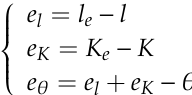
Table 5. The simulation parameters of SCM-VSJ.